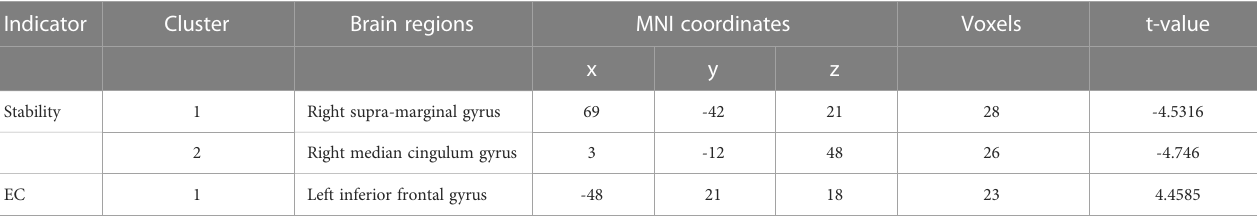
TABLE 3 Brain regions with altered stability and EC in T2DM subjects.